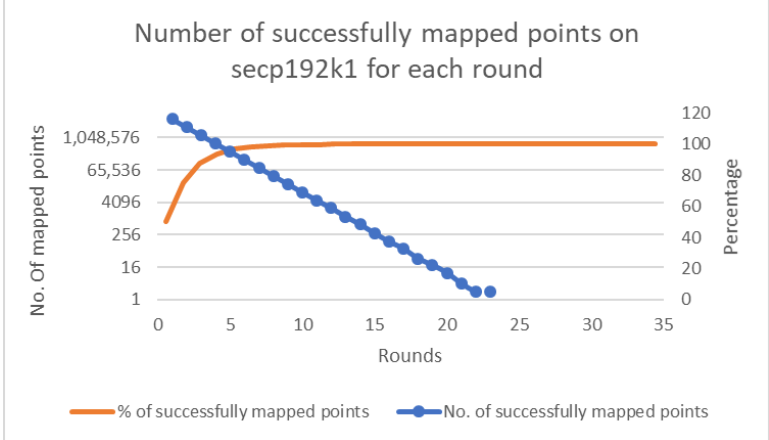
Figure 6. Case 1—Successfully mapped points count to